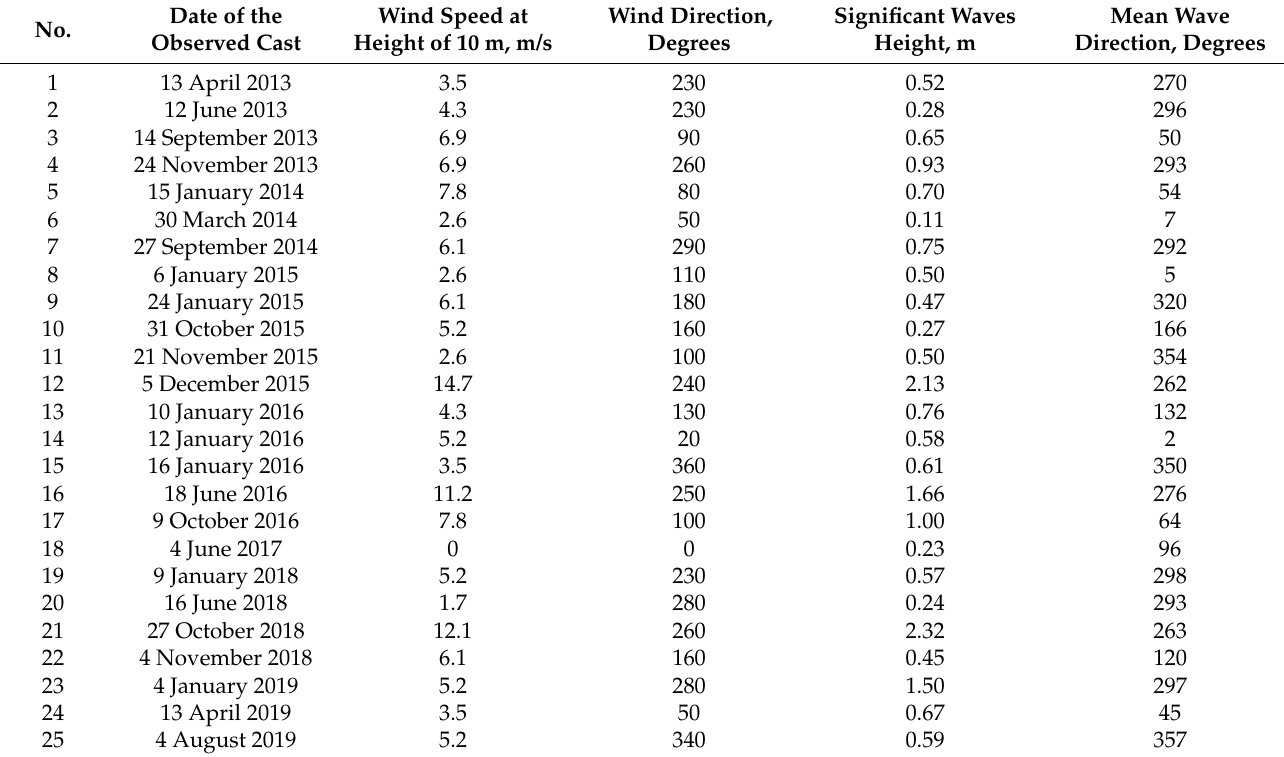
Table 1. Parameters of meteorological and hydrophysical conditions at 12:00 local time (GMT + 2) for each observation.